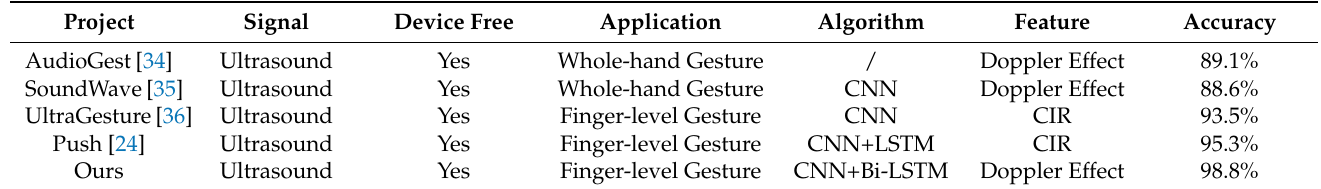
Table 1. Comparison with the word level methods.